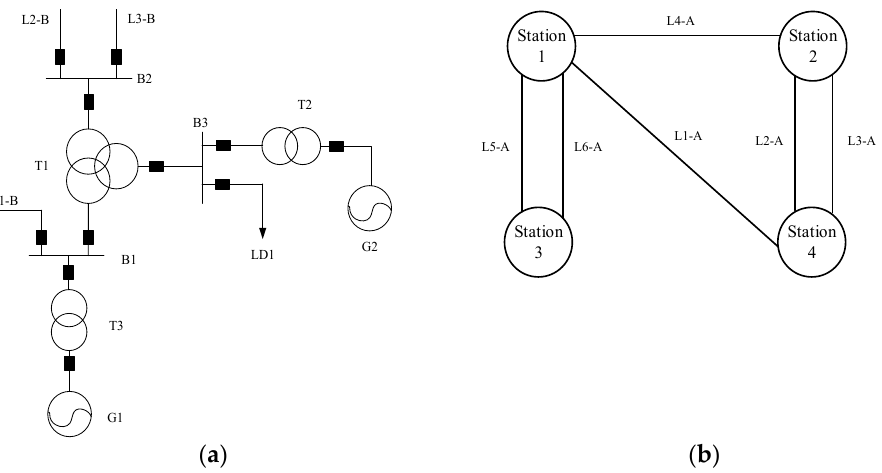
Figure 3. Typical connection diagram: ( a ) station wiring diagram; ( b ) inter-station wiring diagram.